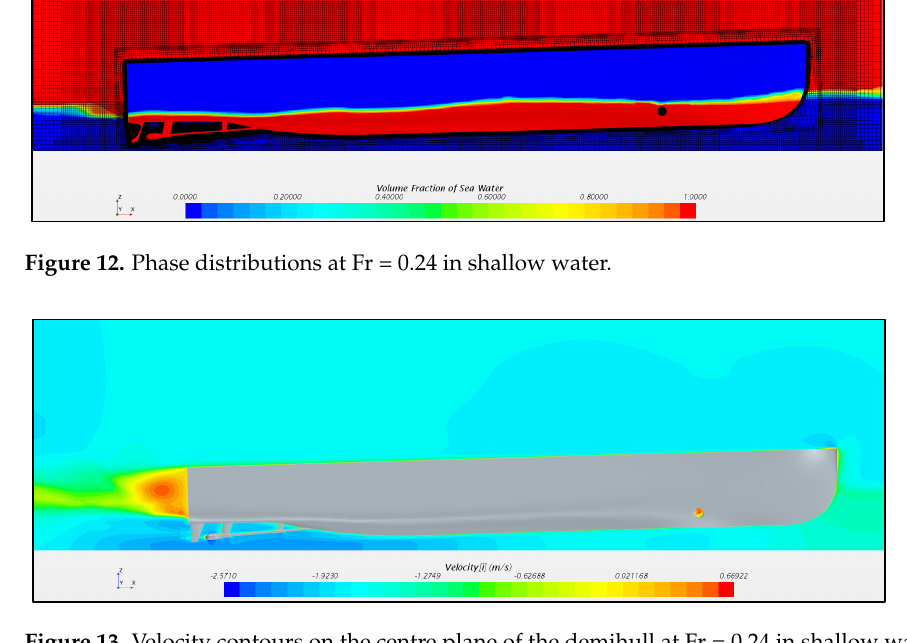
Figure 13. Velocity contours on the centre plane of the demihull at Fr = 0.24 in shallow water.